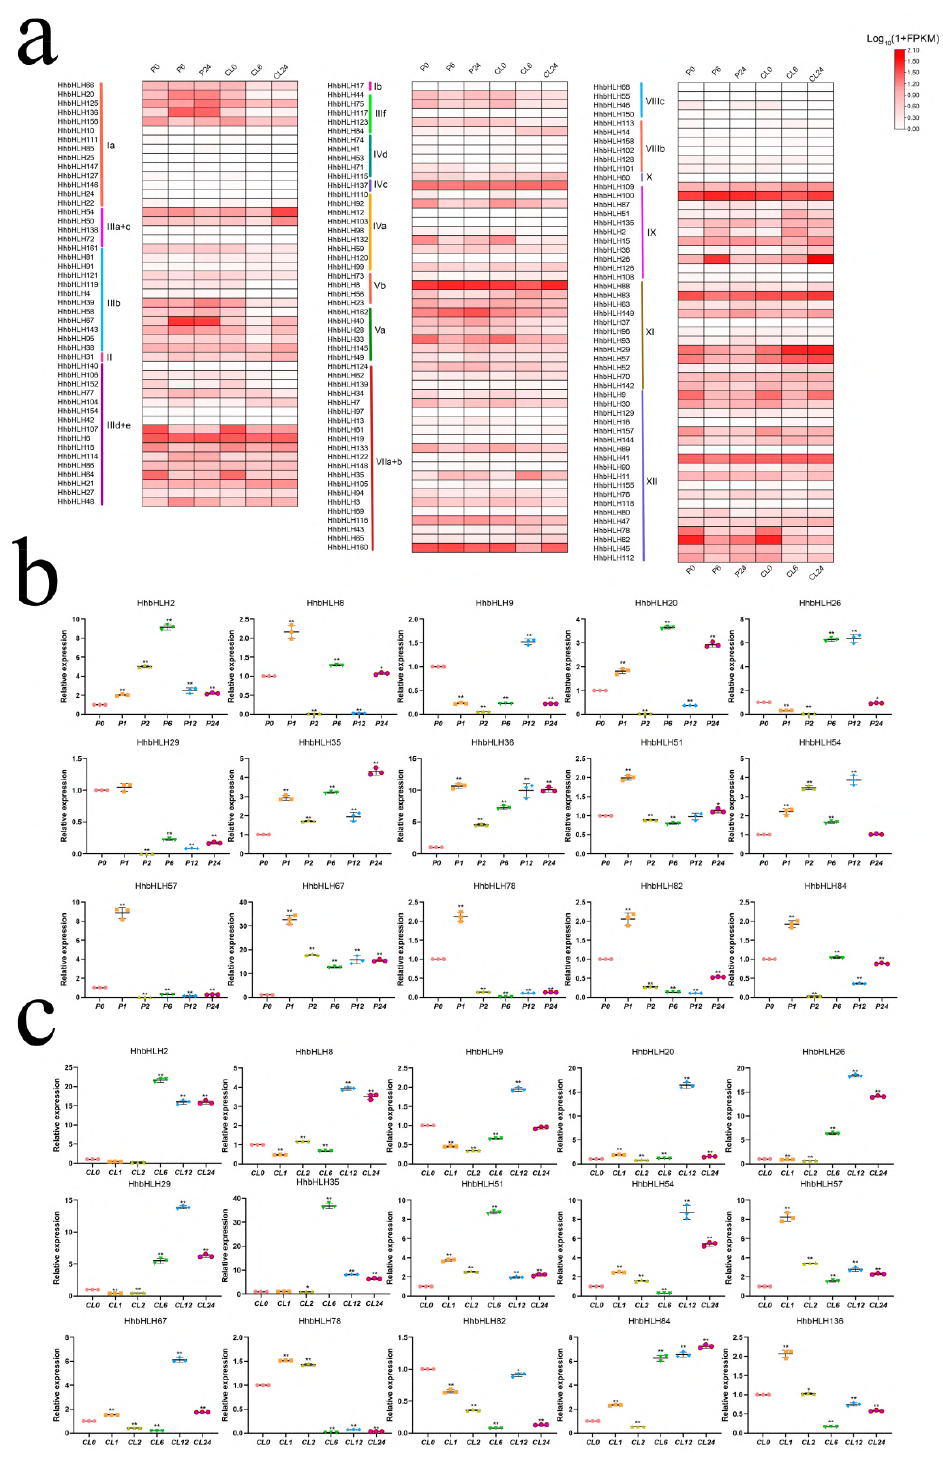
Figure 7. Expression profile of HhbHLHs under drought and salt stresses. ( a ) A heatmap shows the expression level of 162 HhbHLH genes with different subfamilies in salt and drought stress of H. hamabo . Expression differences are observed in different colors. The P0, P6, P24 represent 0 h,6 h, and 24 h were treated with PEG; CL0, CL6, and CL24 represent 0 h, 6 h, and 24 h were treated with NaCl. A color change indicates a change in expression level; white indicates a lower level of expression, whereas red indicates a higher level of expression. ( b ) Relative expression of 15 HhbHLH genes chose at random with PEG treatment, P0, P1, P6, P12, and P24 represent 0 h, 1 h, 2 h, 6 h, 12 h, and 24 h were treated with PEG. ( c ) Relative expression of 15 HhbHLH genes chosen at random with NaCl treatment, CL0, CL1, CL6, CL12, and CL24 represent 0 h, 1 h, 2 h, 6 h, 12 h and 24 h were treated with NaCl. The ACT gene was used to normalize the data, and vertical bars represent standard deviation. Asterisks denote genes that are significantly up-or down-regulated in comparison to the untreated control (* p < 0.05, ** p < 0.01, Student’s t